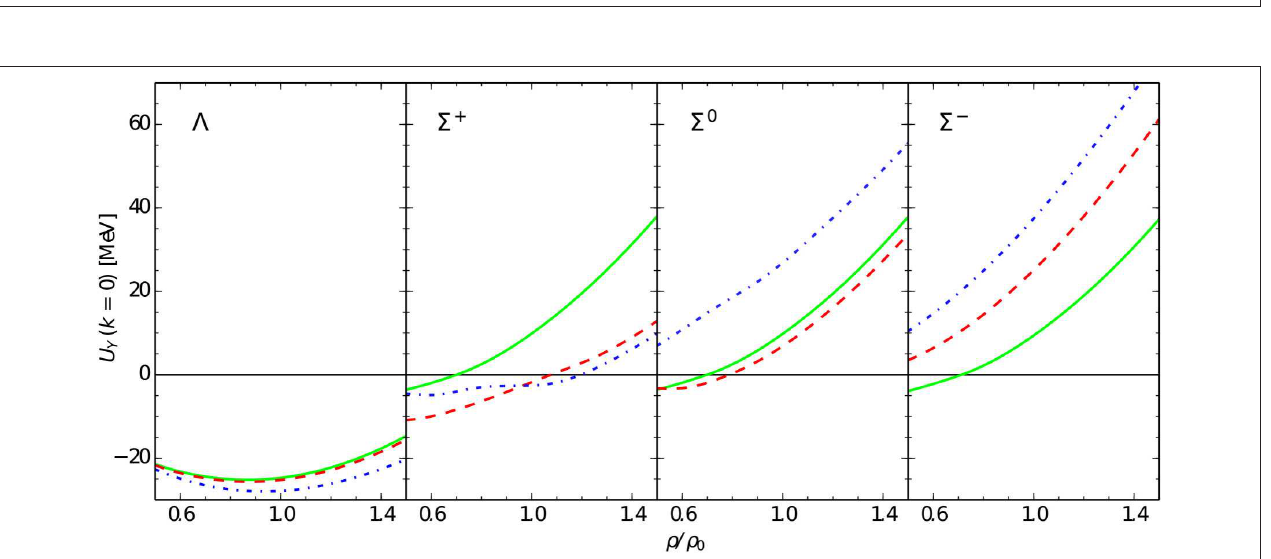
FIGURE 18 | Density dependence of the hyperon single-particle potentials at k a cutoff 3 600 MeV [ 76]. The green solid, red dashed and blue dash-dotted curves are for ρ p =